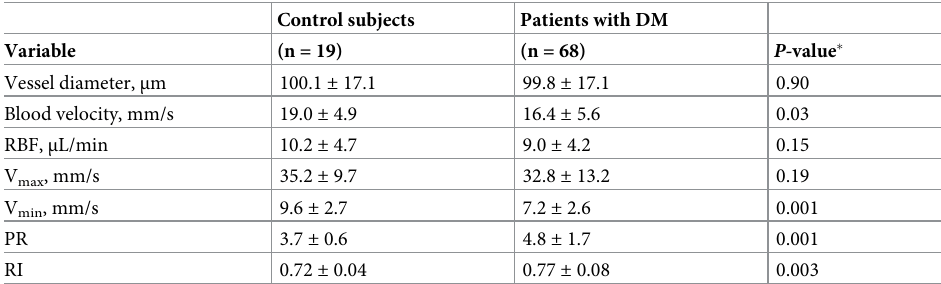
Table 2. Retinal circulatory parameters between control subjects and patients with